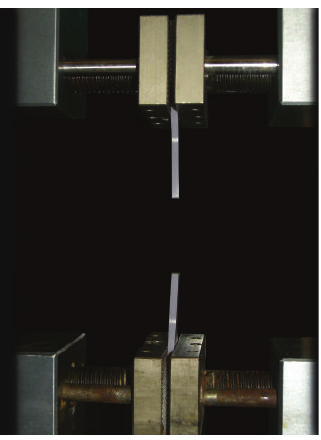
Figure 5: Example of a specimen loaded in tension until failure.